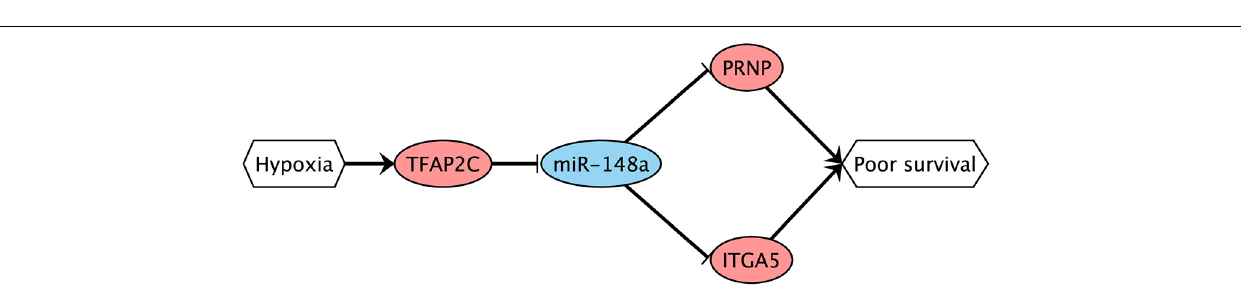
FIGURE 6 | Possible hypoxia-driven regulatory network induced by miR-148a gene silencing. Red nodes are associated with upregulation; blue nodes are associated with downregulation. The arrows and T-shaped lines signify activation and repression, respectively.